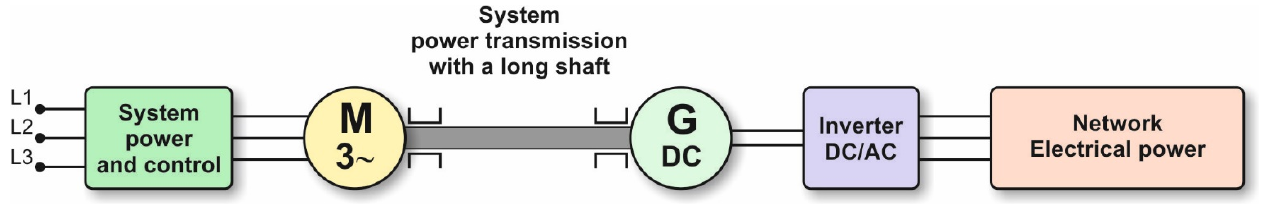
Figure 11. Flow diagram of a laboratory stand for testing of drive systems including elastic connections.